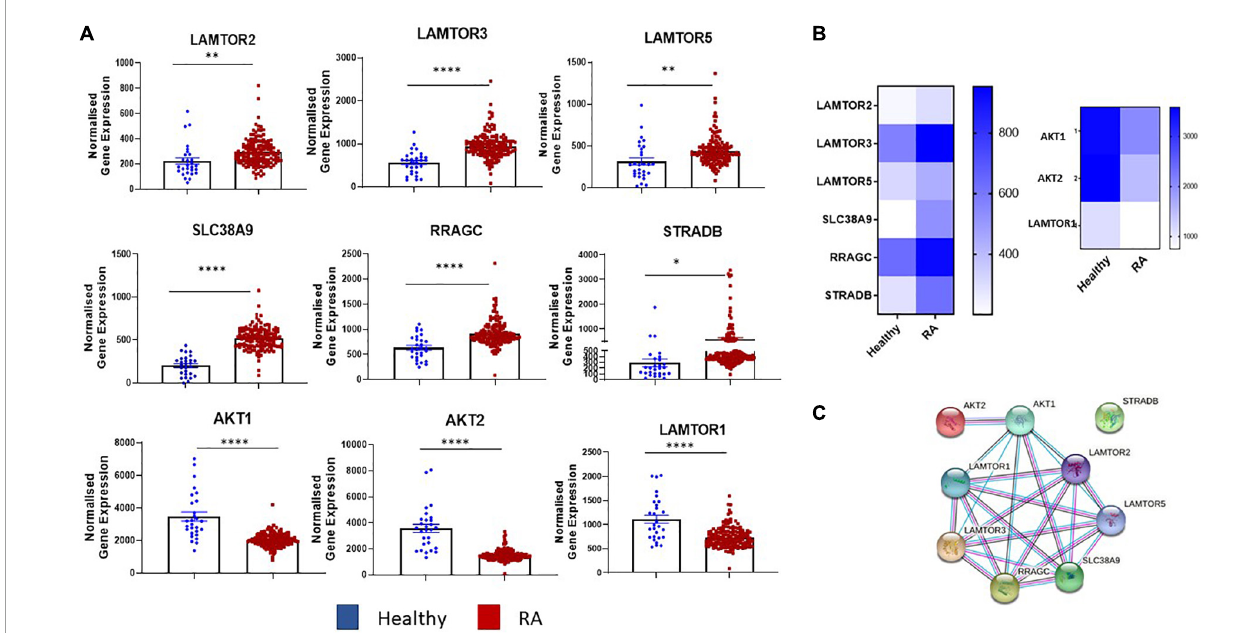
FIGURE1 Dysregulated expression of the mTOR pathway in RA synovial tissue. (A) Bar graphs demonstrating normalized gene expression of key components in the mTOR pathway (LAMTOR1, LAMTOR2, LAMTOR3, LAMTOR5, SLC38A9, RRAGC, STRADB, AKT1, and AKT2) via transcriptomic analysis of RNA-Seq (GEO database GSE89408) on synovial tissue biopsies from healthy donors ( n = 28) RA patients ( n = 151). (B) Clustered heatmap representing DEG involved in metabolism (mTOR pathway) from RASF compared to healthy controls. (C) Known and predicted interactions of dysregulated genes in mTOR pathway. Non-parametric unpaired Mann–Whitney t -test used for comparisons between healthy donors and RA patients. ∗ p < 0.05, ∗∗ p < 0.01, ∗∗∗∗ p <